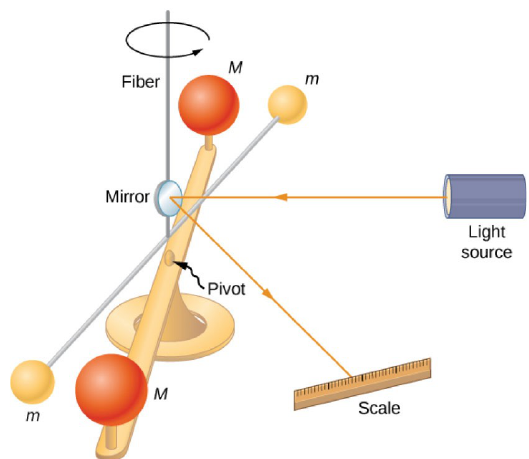
Figure 12. Cavendish Balance Scheme (Samuel, Sanny & Moebs,